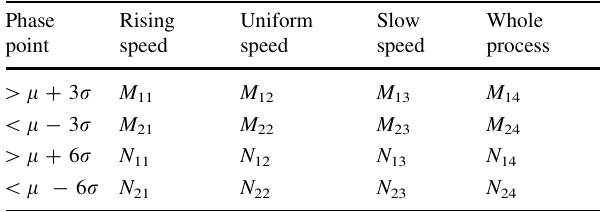
Table 3 Features of current overruns